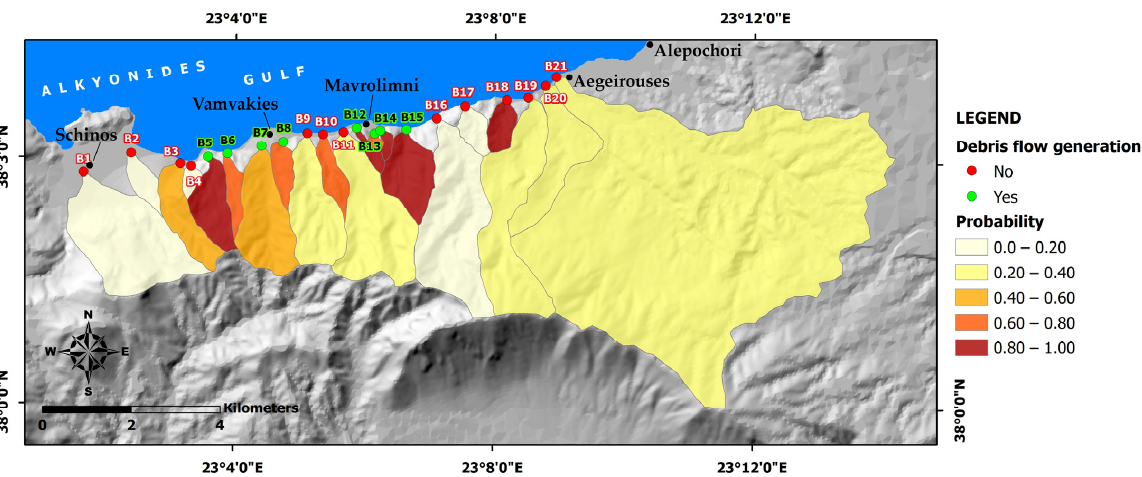
Figure 7. Graph of probabilities per basins, against debris flow occurrence.